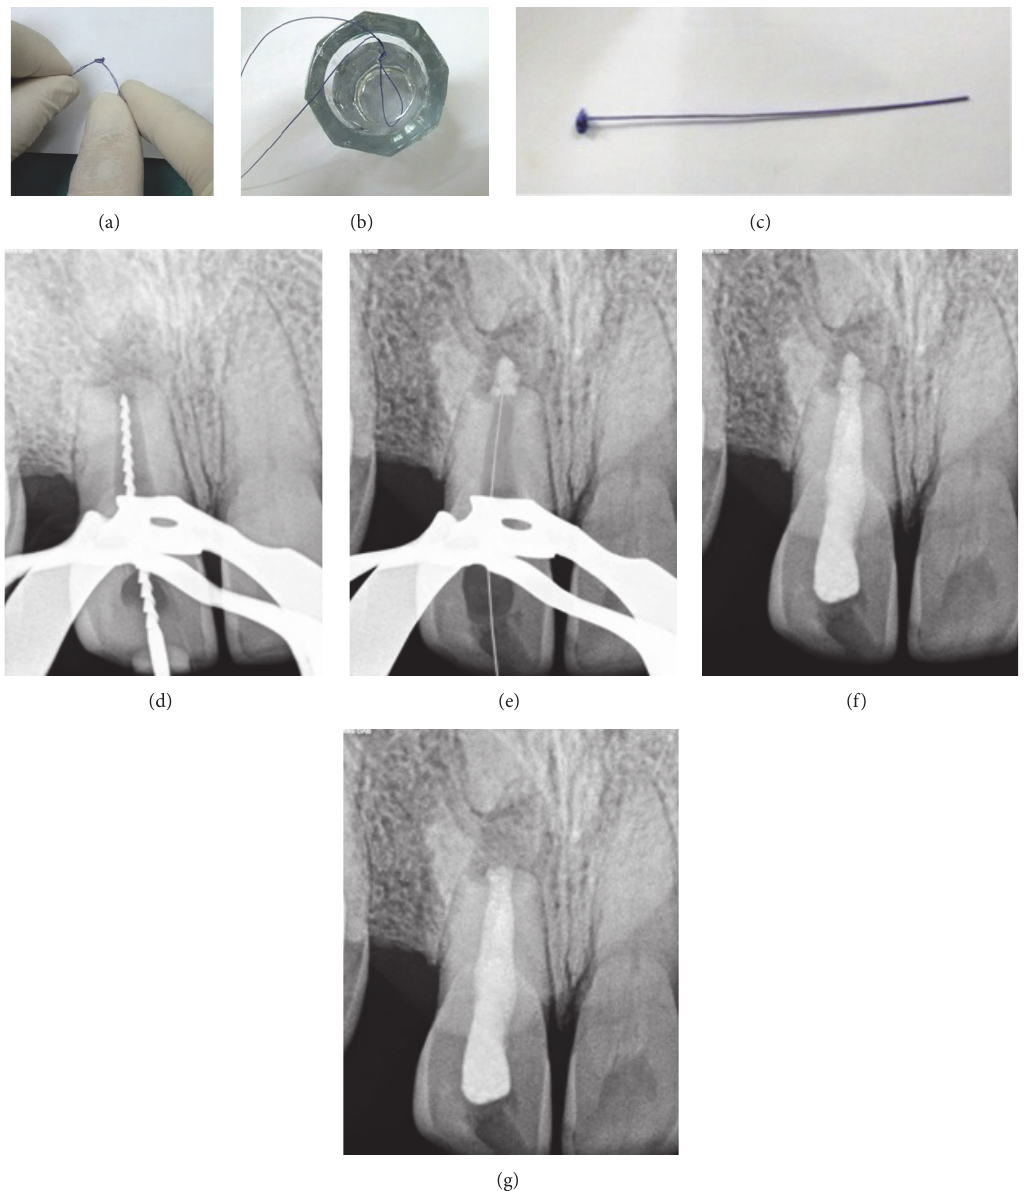
Figure 2: (a)–(c) Fabrication of the matrix. (a) Formation of the “apical matrix” by tying a knot with the suture material. (b) The suture material was kept in the radio-opaque dye for 15 minutes. (c) “Modified suture apical matrix” ready for placement in the root canal. (d)– (g) Intracanal procedures. (d) Working length radiograph. (e) Apical matrix was placed at the apex and the free end was left outside for adjustment. (f) Radiograph taken after placement of MTA, obturation, and coronal restoration with composite. (g) 3-month recall shows absorption of the “apical